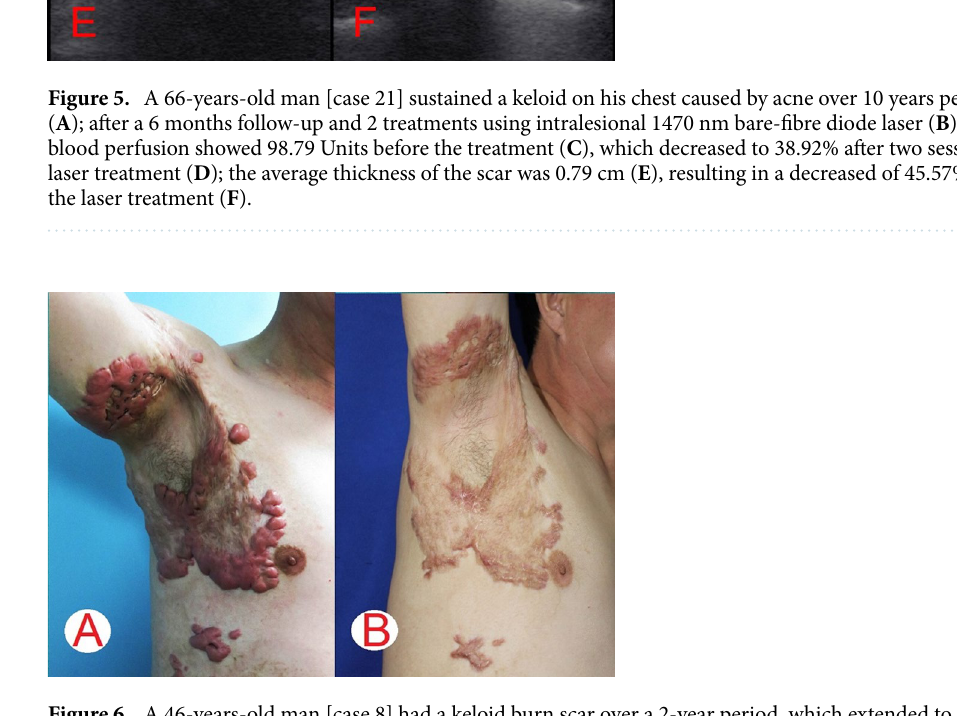
Figure 6. A 46-years-old man [case 8] had a keloid burn scar over a 2-year period, which extended to his chest and arm ( A ); after a 6 months follow-up and 3 laser sessions the patient achieved significant cosmetic and functional outcomes ( B